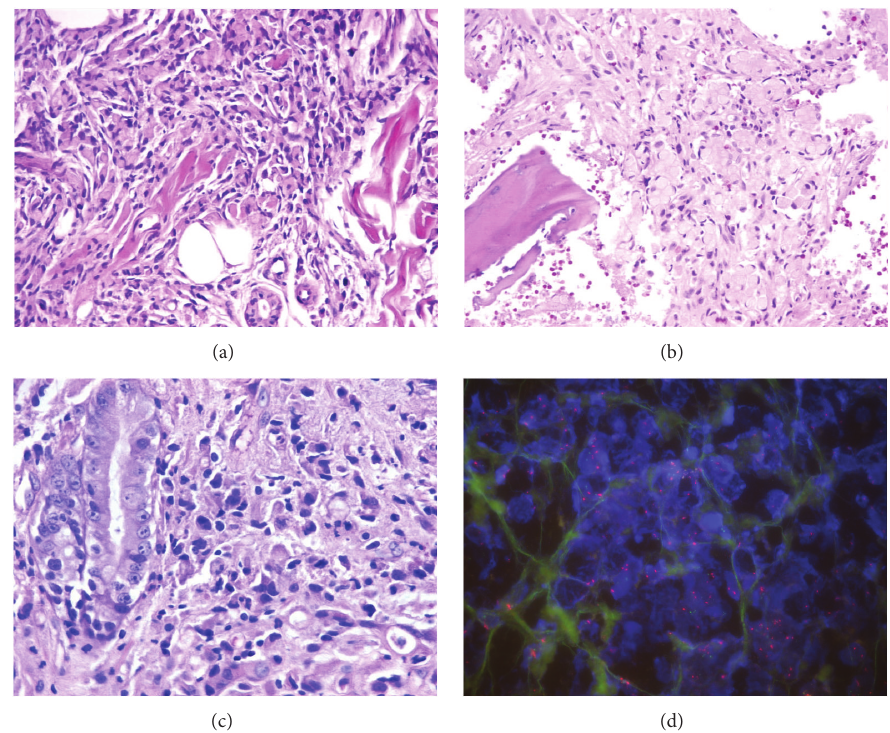
Figure 2: (a) Invasive and signet ring celled tumor infiltration on the dermis between the collagen fibers (HEX200). (b) In the paratrabecular area between the bone trabeculas, fibrosis and signet ring celled tumor are being observed (HEX100). (c) Signet ring cell-like tumor cells with large hyperchromatic nucleus in the stomach mucosa (HEX200). (d) HER-2-neu positiveness determined by the FISH method in the